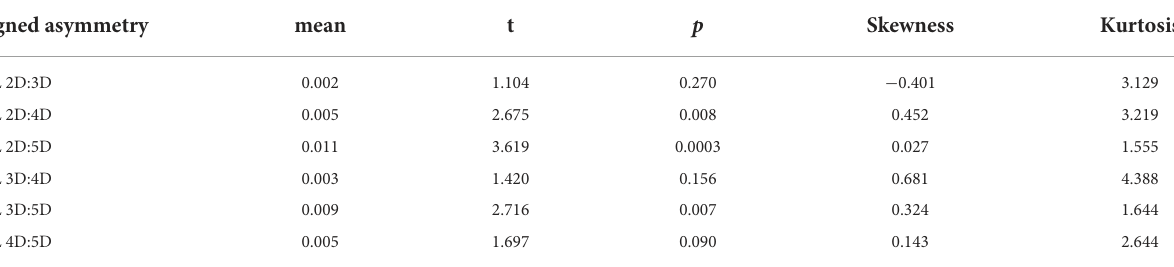
TABLE 1 Signed digit ratio asymmetries (Right digit A/Right digit B)–(Left digit A/Left digit B). One-sample t -test (mean set at zero)